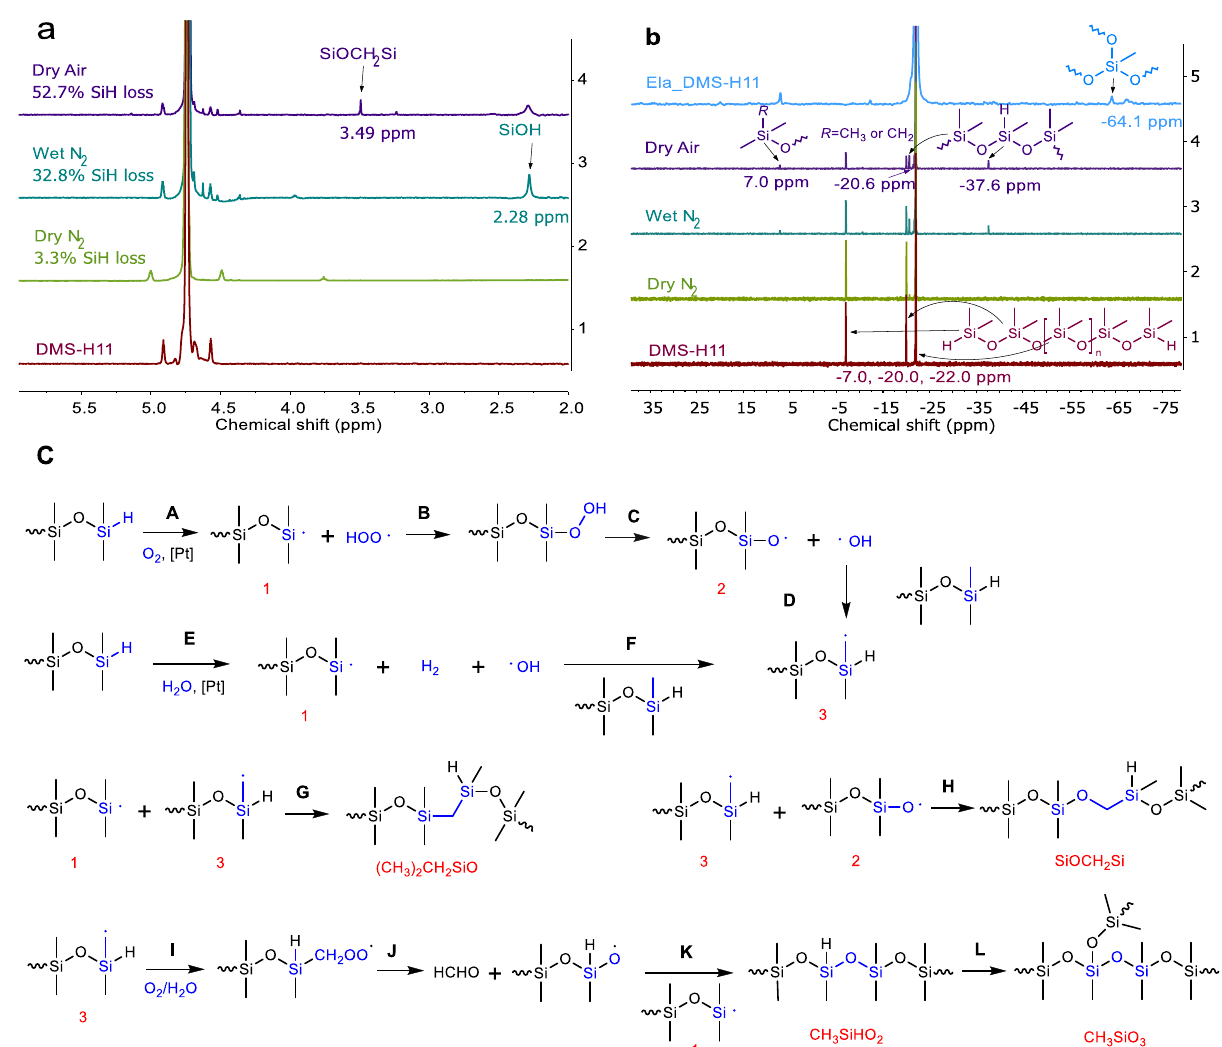
Fig. 2 Mechanism studies of crosslinking of a telechelic Si – H functional PDMS. a 1 H NMR spectra and b 29 Si NMR spectra of a telechelic Si – H functional PDMS (DMS-H11) and its reaction products after heating at 100 °C for 48 h under dry N 2 , wet N 2 , and dry air conditions, respectively. Additionally, 29 Si solid-state NMR spectrum of the elastomer (Ela_DMS-H11) cured under normal air atmosphere is shown in ( b ). c Proposed mechanism of crosslinking Si – H functional groups in the presence of oxygen, water, and a